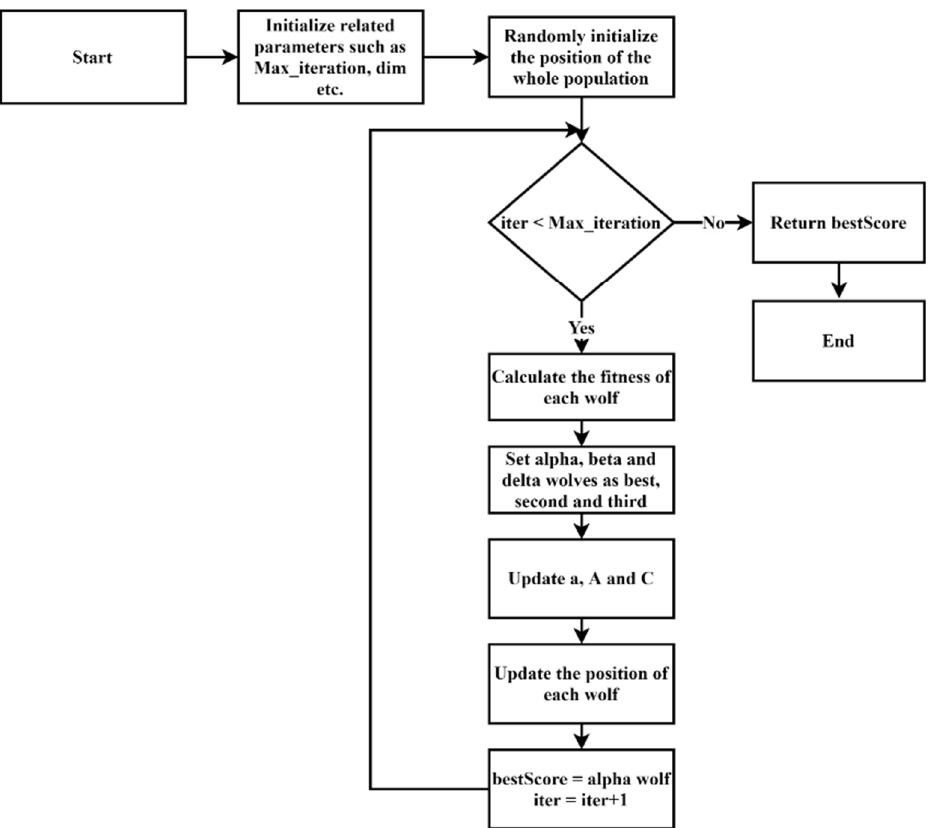
Figure 1. Flowchart of the GWO.